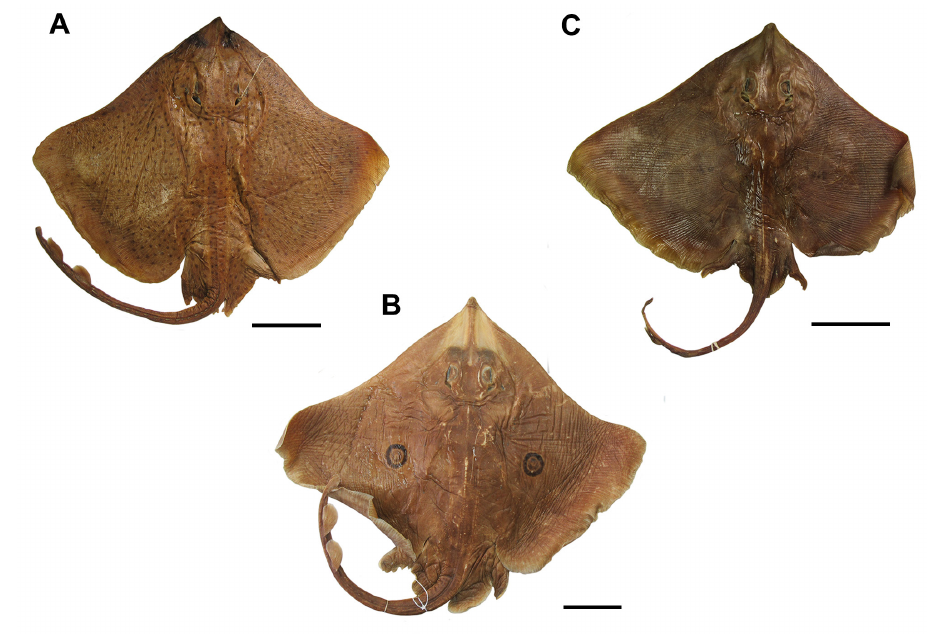
FIGURE 4 | Color pattern of Atlantoraja species. A , A. castelnaui , UERJ 1853, male, 593 mm TL. B , A. cyclophora , MNRJ 117184, female, 583 mm TL. C , A. platana , UERJ 1383, male, 372 mm TL. Scale bars = 10 cm.